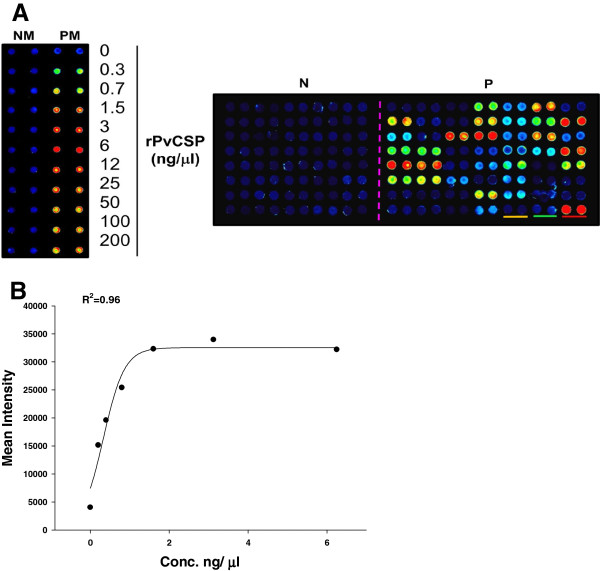
Development of a protein array platform for profiling antibody responses to P. vivax infection. (A) Left panel. Different concentrations of rPvCSP were probed with pooled human serum (left duplicate, negative serum; right duplicate, positive serum). Right panel. rPvCSP (6 ng/μl) reacted with individual serum samples in duplicates. Left phase of slide: vivax negative serum samples; Right phase of two slides: vivax positive serum samples. Red bar, pooled positive sera reacted with rPvCSP; Green bar, pooled vivax negative sera reacted with rPvCSP; Yellow bar, 10 OD wheat germ extract reacted with rPvCSP. NM: negative P. vivax patient sera mixture; PM: positive P. vivax patient sera mixture; N: individual negative serum; P: individual positive serum. (B) Correlation between spot intensities and the concentration of rPvCSP.